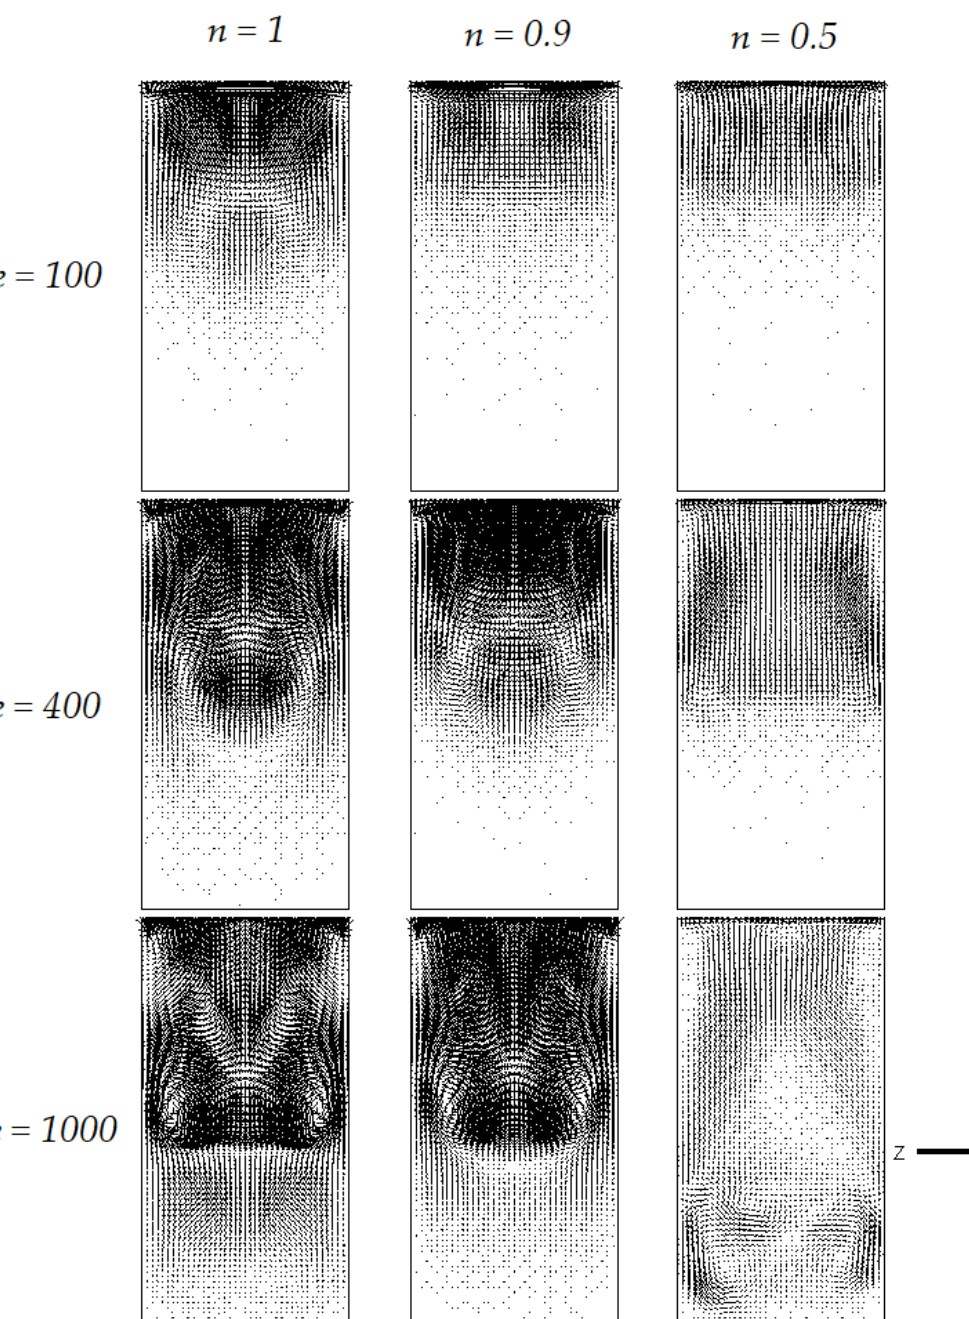
Figure 12. Velocity vector in plane of Φ for a cavity of δ = 2 together with different Reynolds numbers as well as different values of n